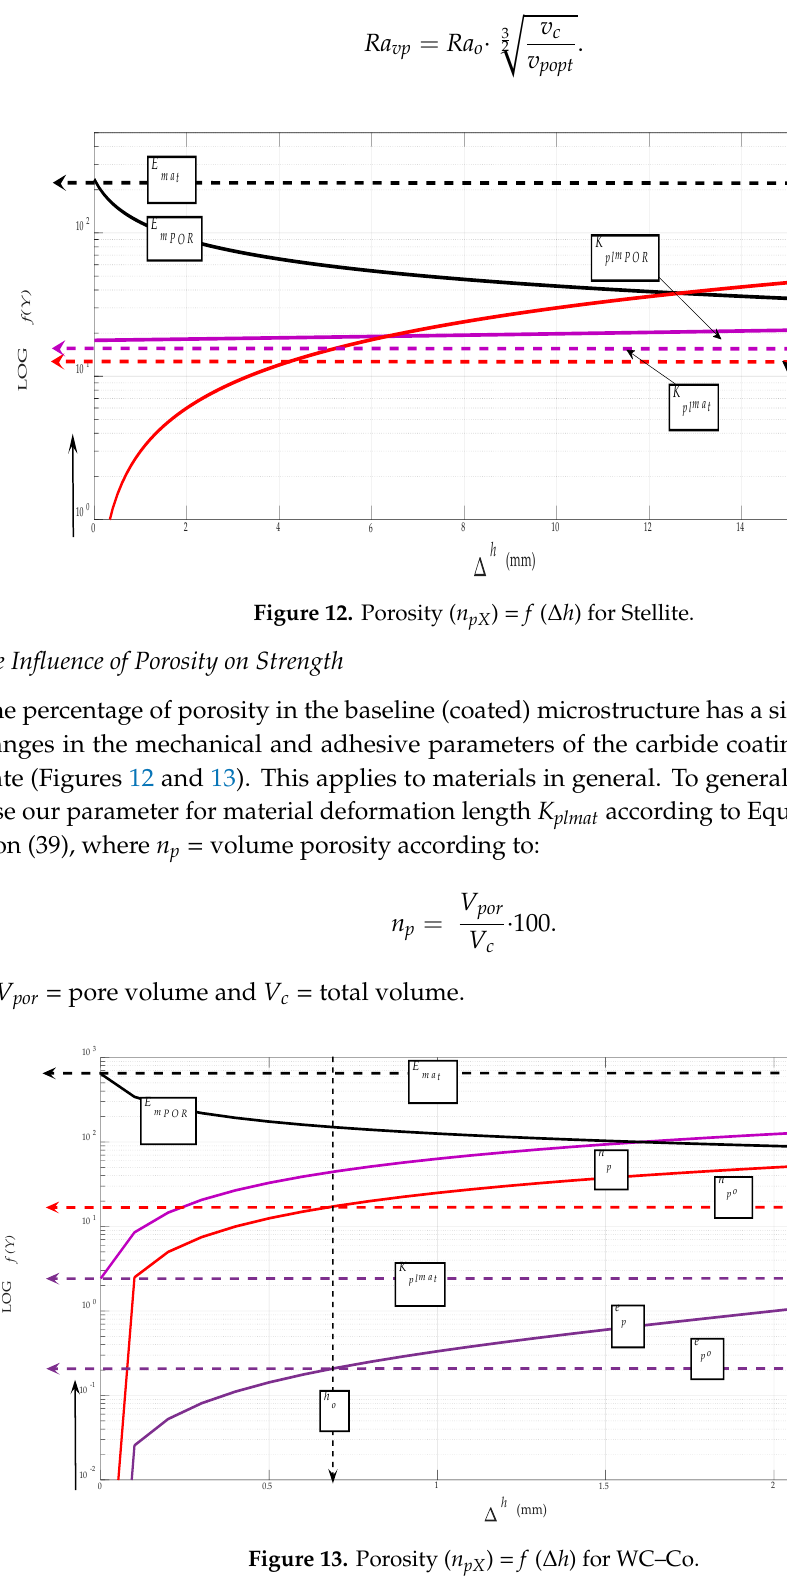
Figure 13. Porosity ( n pX ) = f ( ∆ h ) for WC–Co.